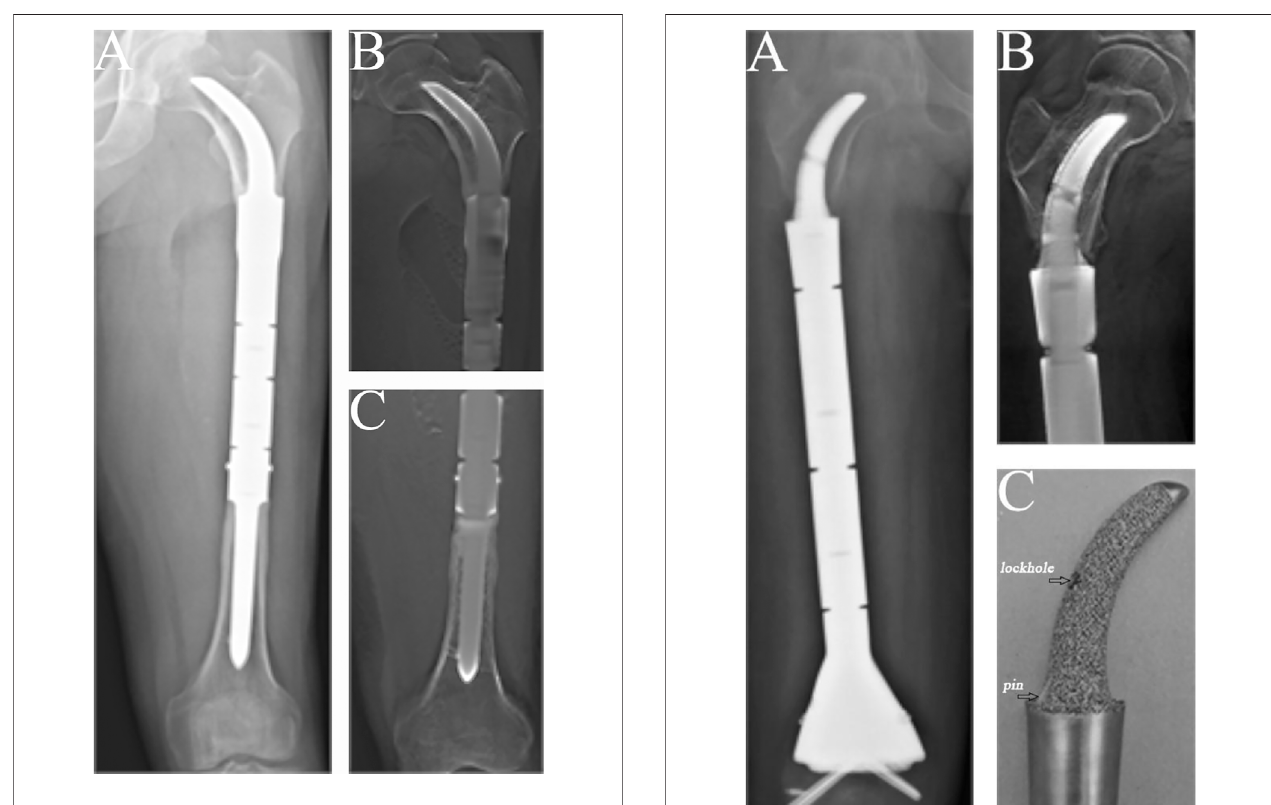
FIGURE 3 | Radiographs showing the 57-months postoperative views of the customized cementless intercalary endoprosthesis with an intra-neck curved stem placed during treatment for an osteosarcoma. (A) Posteroanterior radiograph of the entire femur. (B) Posteroanterior tomosynthesis withShimadzuMetal Artefact Reduction Technology (T-smart) views of the stem insertion region in the proximal femur. (C) Posteroanterior T-smart views of the stem insertion region in the distal femur.